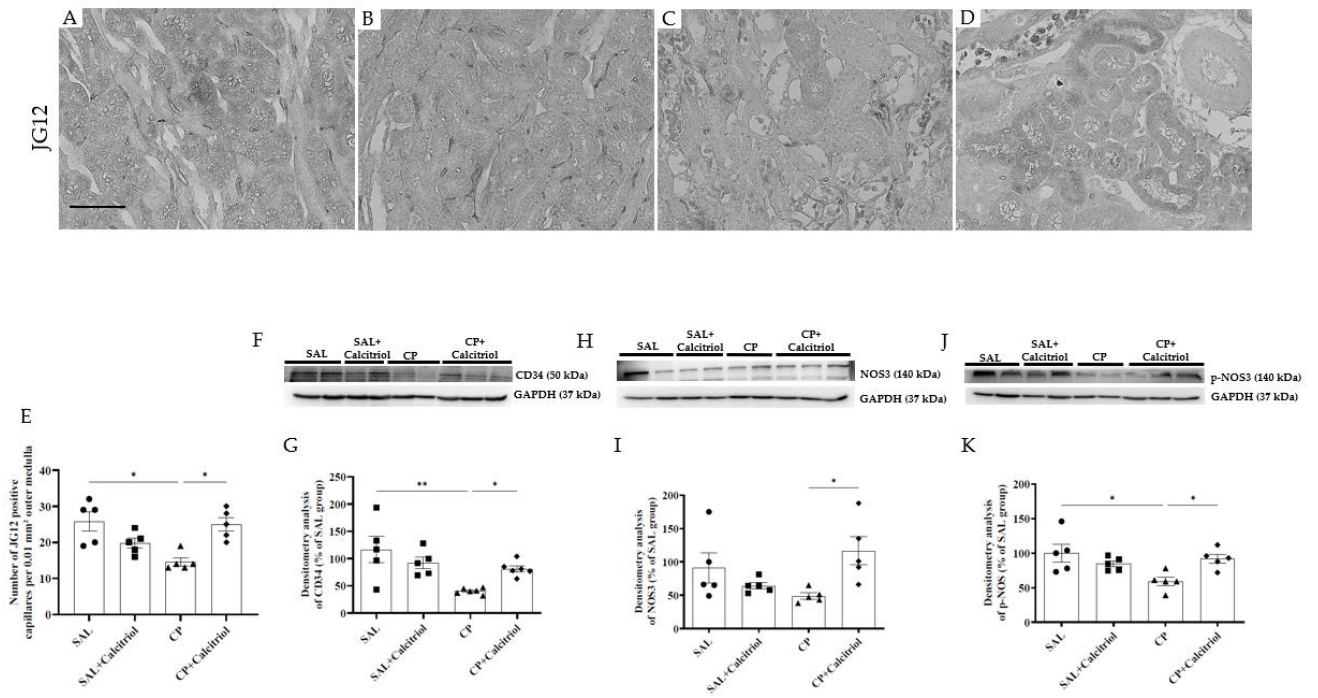
Figure 5. Immunolocalization of JG12 ( A – D ) in the renal outer medulla of the SAL ( A ), SAL + calcitriol ( B ), CP ( C ) and CP + calcitriol ( D ) animals. The bar indicates 50 μm. The number of JG12-positive capillaries in all experimental groups ’ outer renal medulla ( E ). Western blot analysis of CD34 ( F ), NOS3 ( H ) and p-NOS ( J ) in the renal tissue from all experimental groups (SAL, SAL + calcitriol, CP, CP + calcitriol). Densitometry of CD34 ( G ), NOS3 ( I ) and p-NOS ( K ). The densitometric ratio between CD34, NOS3, p-NOS and GAPDH was calculated, and the data are expressed in comparison with the control group, with the mean control value (± SEM) designated as 100% and expressed as mean ± SEM ( n = 5 – 8 for each group). Blots are representative images of independent experiments. * p < 0.05; ** p < 0.01.